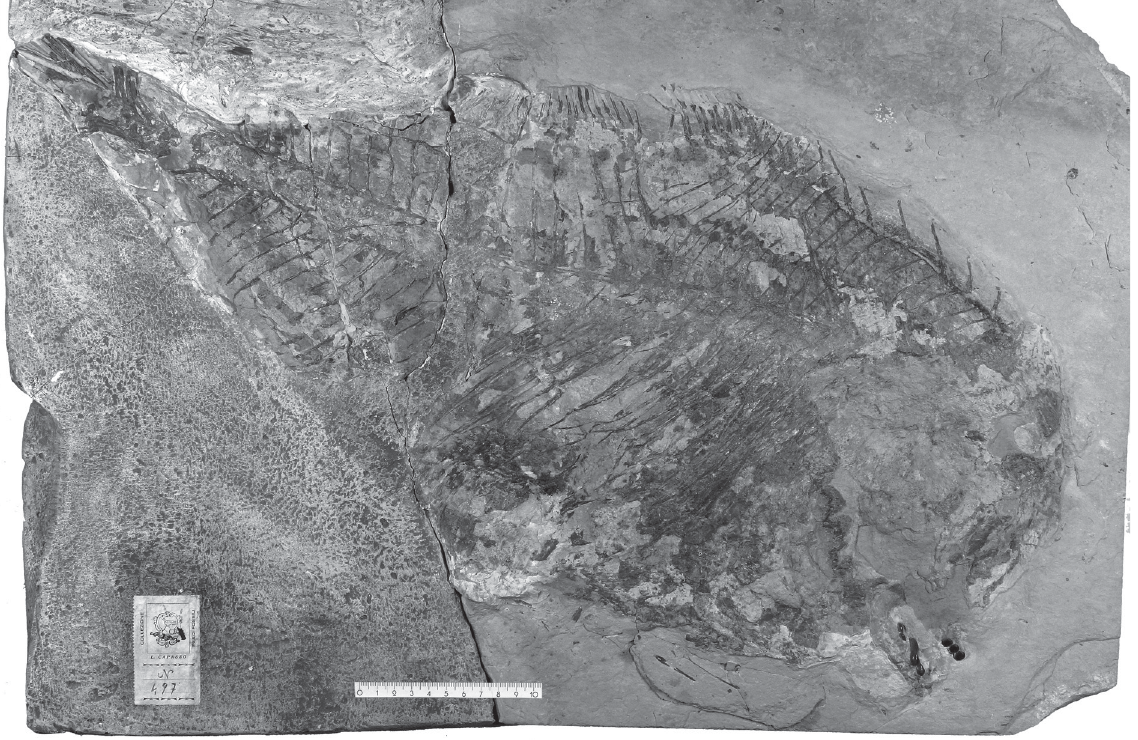
Fig. 13. Sigmapycnodus giganteus gen. et sp. nov., holotype (CLC S-497b), slab